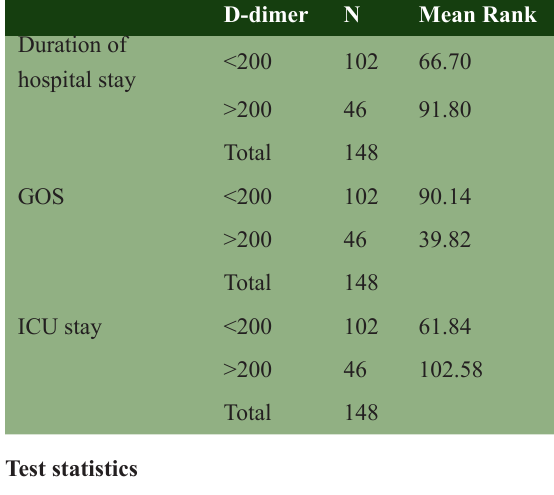
Table 3: Man-Whitney test showing correlation between D-dimer and duration of hospital stay, duration of ICU stay and GOS Man-whitney Test (Ranks) D-dimer N Mean Rank